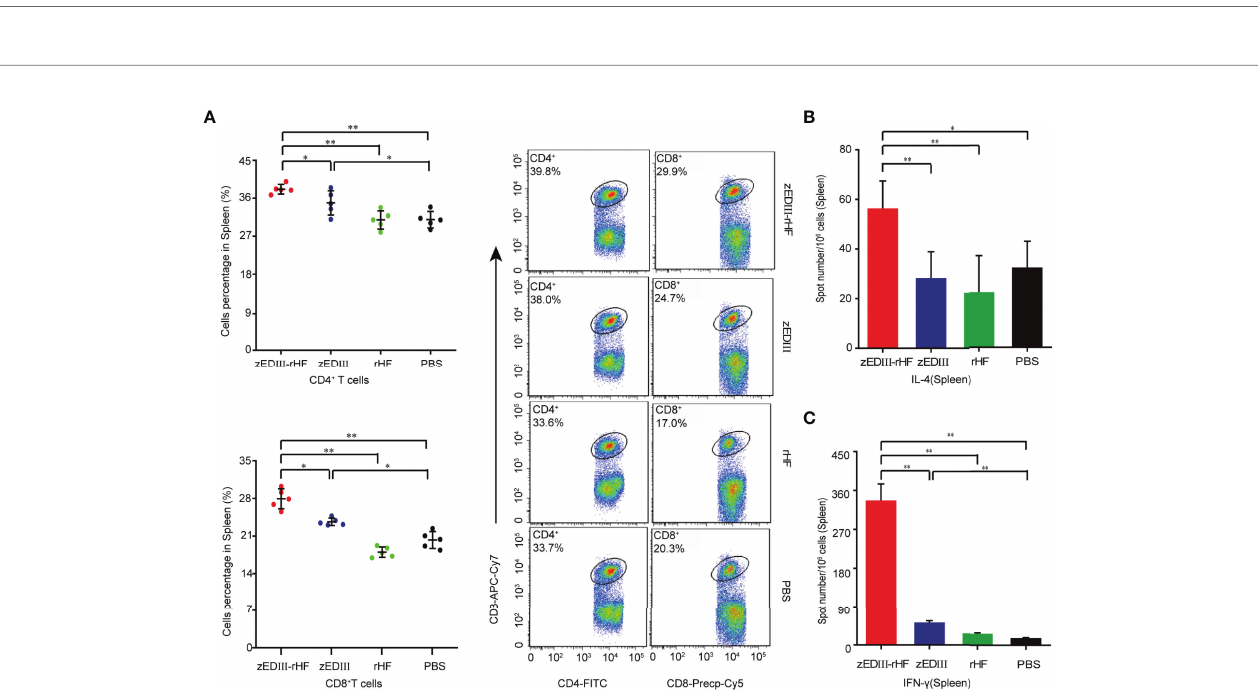
FIGURE 3 | Cellular immunity induced by zEDIII-rHF in mice. Cellular immune responses were assessed on day 28 after the second booster immunization. (A) The percentages of CD4 + and CD8 + T cells in the spleen were determined by fl ow cytometry. (B) IL-4-secreting lymphocytes in the spleen, n = 3. (C) IFN- g -secreting lymphocytes in the spleen were identi fi ed via an ELISPOT assay, n = 3. The data in 3a-3c are shown as the mean and standard deviation (mean ± SD) analyzed by Student ’ s t-test; * P < 0.05 , ** P < 0.01